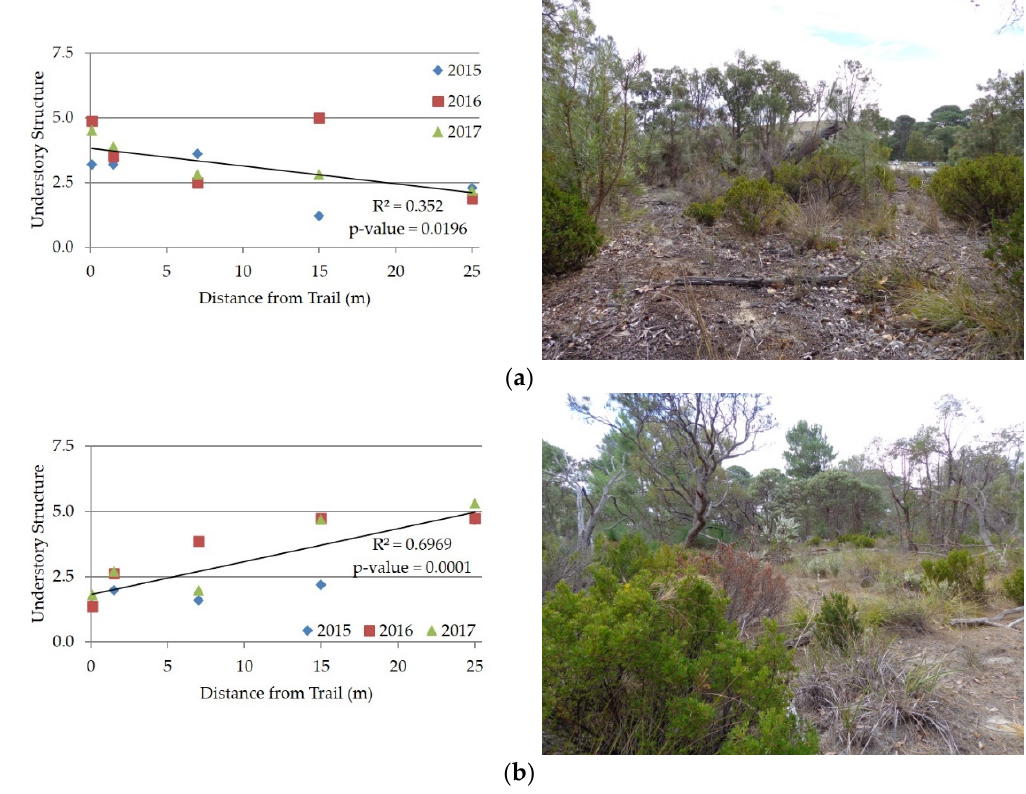
Figure 3. Change in the structure of the understory vegetation (highest complete row of 10 × 0.01 m × 0.01 m cells in a 1 m × 1 m frame) with distance (in meters) from recreation trails in fenced ( a ) and unfenced ( b ) Banksia and eucalypt woodland at Murdoch University and contextual photographs of vegetation at both sampling location. Example photographs taken at waist height from the 15 m quadrat looking back along transects towards the recreation trail.